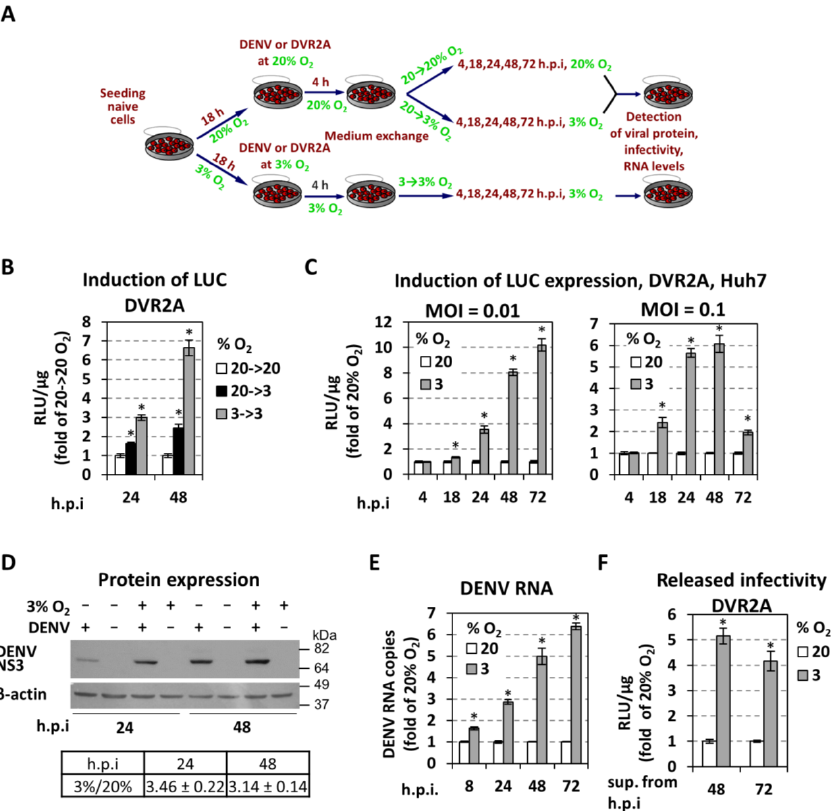
Figure 2. Low oxygen tension enhances the production of DENV in hepatoma Huh7 cells. ( A ) Schematic representation of the experimental procedure. Cell culture produced DENV or DVR2a virus stocks were used for infection of naive cells that were seeded at 30% confluence (to avoid pericellular hypoxia) and preincubated for 18 h at 20% or 3% O 2 , respectively. After 4 h cells were washed twice with fresh culture medium, new medium was added and the incubation of cells continued as follows: cells preincubated at 20% O 2 were further incubated at either 20% (referred to as 20 → 20% or 20%) or 3% O 2 (referred to as 20 → 3%) whereas cells preincubated at 3% O 2 were further incubated at 3% O 2 (referred to as 3 → 3% or 3%). At the indicated time-points, cells were lysed and the expression of virus-related proteins, virus titers, and the amounts of viral RNA were determined. ( B – C ) Hypoxic conditions enhance DENV replication. Huh7 cells cultured under specified oxygen conditions were infected with DVR2A at MOI 0.1 ( B ) and MOI 0.1 or 0.01 ( C ), lysed at the indicated time-points and R-luc activity was measured. Values are expressed as RLU/ µ g of total protein amount and normalized to those obtained with 20 → 20% (B) or 20% (C) O 2 cells (each time-point set to one). ( D ) (Top) Western blot analysis of DENV NS3 protein (top) and β -actin (bottom) of DENV- and non-infected cells, incubated as specified in the top of each lane. Infection was performed with DENV at an MOI of 0.5 and cells were lysed 24 or 48 h p.i. β -actin served as a loading control. Condition of 20% O 2 is indicated as “ − “ and 3% O 2 as “+“. Numbers on the right refer to the positions of molecular mass marker proteins. A representative experiment is shown. (Bottom) Image quantification of NS3 signals (mean values from 3 independent repetitions), normalized to β -actin and to the values obtained with cells cultured under 20% O 2 . ( E ) Viral RNA copies in cells infected with DENV at MOI = 0.01 were determined by RT-qPCR. YWHAZ mRNA levels were used for normalization. Values obtained with 20% O 2 cells were set to one for each time-point. ( F ) Virus amounts released from Huh7 cells previously infected with DVR2A (MOI = 0.1) at the indicated oxygen conditions. Supernatants were collected at 48 and 72 h p.i. and used to infect naive Huh7 cells (infected and incubated at 20% O 2 ), 72 h post-infection the cells were lysed and luciferase activity was measured and normalized to total protein amount. Values obtained with 20% O 2 cells were set to one. In all panels, bars represent mean values from at least three independent experiments in triplicate. Error bars indicate standard deviations. * p < 0.001 vs. 20% O 2 cells, for 8–72 h p.i (Student’s t